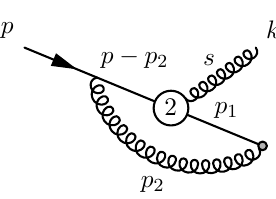
Figure 7 . One of the diagrams contributing to the one-loop collinear functions. Through calcula- tion of this diagram using Feynman rules from [35] we can obtain the J 1 and J 6 collinear functions, corresponding to insertions of